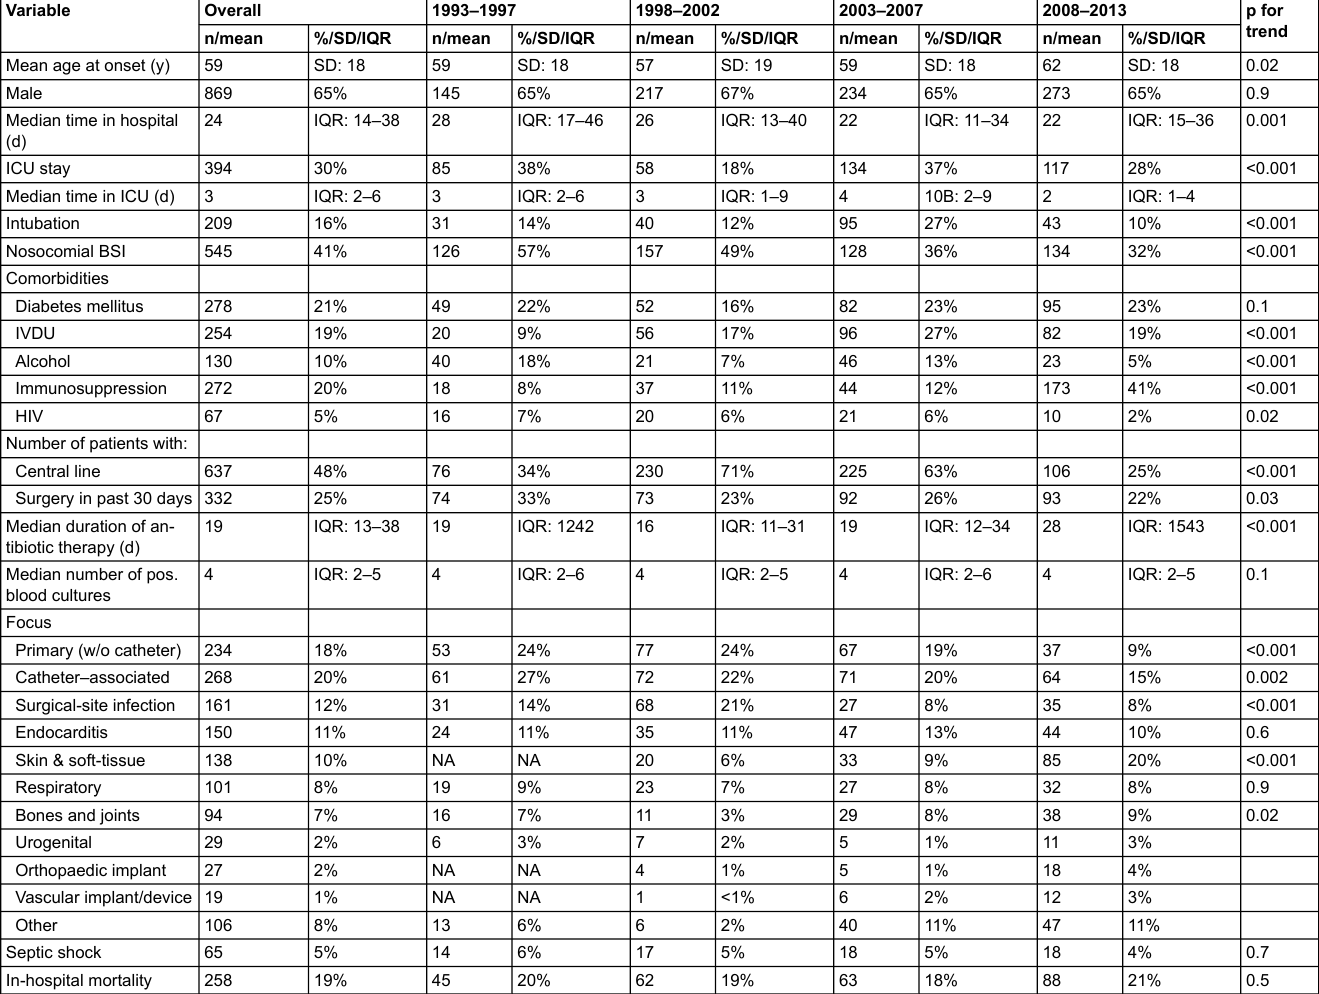
Table 1: Baseline characteristics of 1328 patients with MSSA BSI over 20 years, overall and stratified.